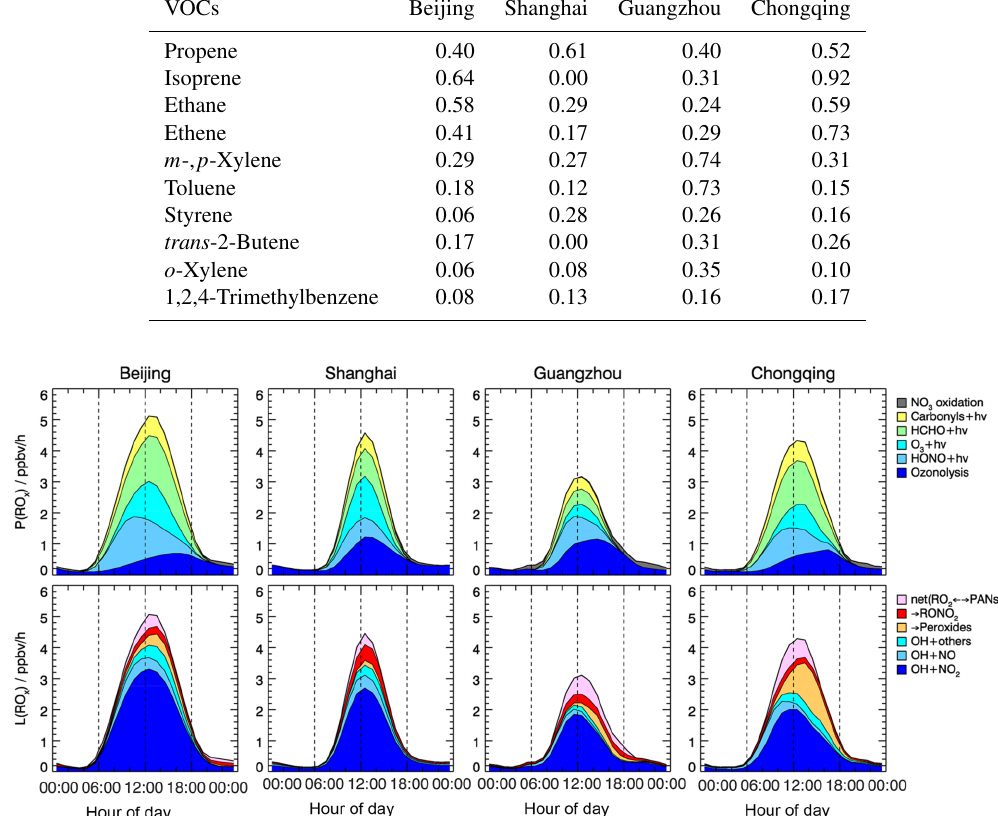
Figure 7. Hourly averaged primary sources and sinks of RO x radicals derived from model calculations for four measurement